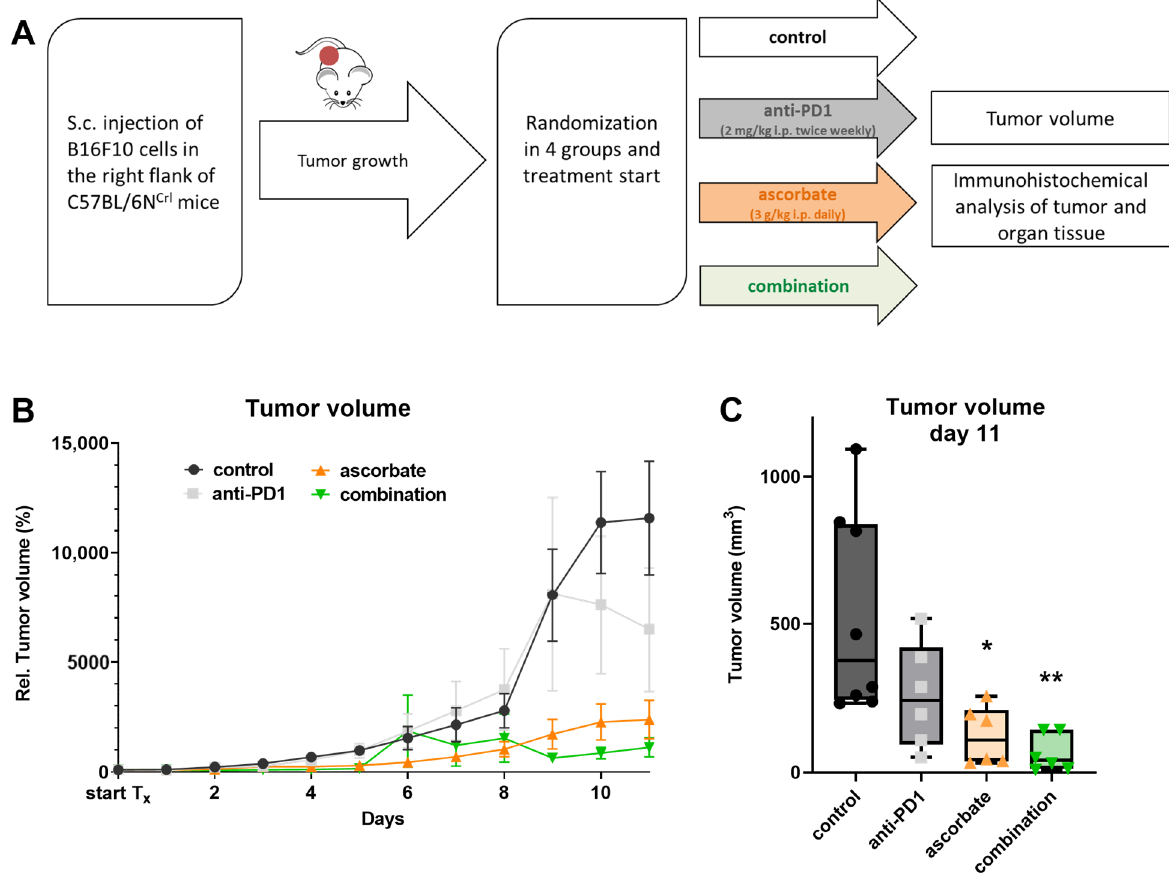
Figure 4. Effects of ascorbate and anti-PD1 in vivo in a B16F10 mouse model injected subcutaneously with the B16F10 melanoma cell line. ( A ) In vivo mouse experiment treatment regimen. ( B ) Relative tumor volume progression of female C57BL/6N Crl during ascorbate treatment (3 g/kg i.p., daily), anti-PD1 treatment (2 mg/kg i.p., twice per week), and the combination of ascorbate and anti-PD1 treatment. ( C ) Endpoint measurement of tumor volume at day 11 after treatment initiation with ascorbate (3 g/kg i.p., daily), antiPD1 (2 mg/kg i.p., twice per week), and both treatments combined. Relative tumor volumes were calculated in relation to the tumor volume at treatment initiation, respectively. Mean values of normalized tumor volume ± SEM are shown. *: p ≤ 0.05; **: p ≤ 0.01. i.p., intraperitoneal; PD1, programmed cell death protein 1, SEM, standard error of the mean.